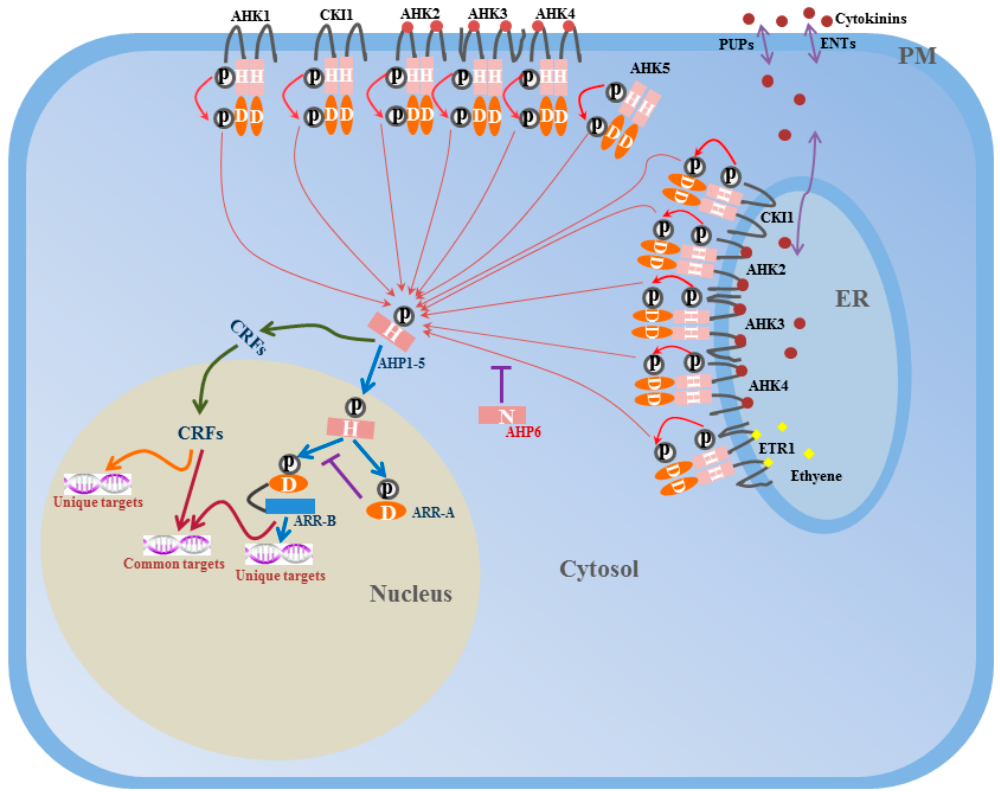
Figure 1. Model for two-component system signal transduction pathway in Arabidopsis . Signal perception induces autophosphorylation of the conserved histidine residue (H) in the histidine kinase (HK) domain of AHKs localized in the PM or ER. Then the phosphoryl group (P) is subsequently transferred to a conserved aspartate residue (D) of the C-terminal receiver domain. AHP proteins accept the signal from AHKs, and transfer the phosphoryl group to the ARR-A or ARR-B. AHP6 lacks the conserved histidine residue and negatively regulate phosphate transfer process. ARR-B are transcription factors which could positively regulate downstream targets while ARR-A negatively regulate ARR-B expressions. As a parallel branch, AHP proteins may also transfer the phosphoryl group to another transcription factors, cytokinin response factors (CRFs). Upon phosphorylation, CRFs shuttle from cytosol to the nucleus and regulate downstream targets. CRFs and Type-B ARRs share some common targets while also having their own specific targets. Cytokinin and ethylene are indicated by red dot and yellow diamond, respectively. PUPs (purine permeases) and ENTs (equilibrative nucleotide transporters) are cytokinin transporters. Figure indicates a whole cell. ER, endoplasmic reticulum; PM, plasma membrane; H, histidine residue; D, aspartate residue; P, phosphoryl group; ARR-A, Type A ARRs; ARR-B, Type B ARRs.